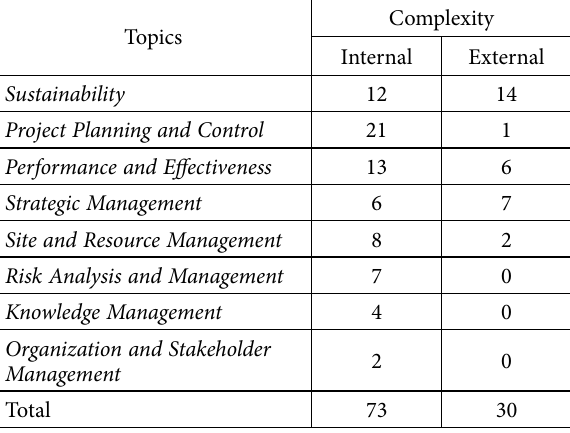
Table 2. The eight topics and types of complexity issues